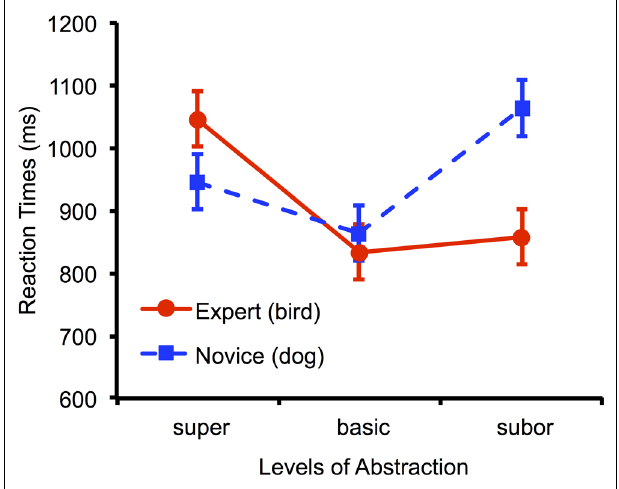
FIGURE 1 | Mean correct categorization response times for a novice domain (dogs) and an expert domain (birds) measured online. FollowingTanaka andTaylor (1991), bird experts were tested in a speeded category verification task where they categorized images at the superordinate ( animal ), basic ( bird or dog ), or subordinate (specific species or breed) level. In their novice domain (dogs), a classic basic-level advantage was observed, whereby categorization at the basic level was significantly faster than the superordinate ( t 22 = 2.67, p = 0.014) and subordinate level ( t 22 = 6.75, p < 0.001). In their expert domain (birds), subordinate categorization was as fast as basic-level categorization ( t 22 = 0.81, p = 0.429).This replication was conducted using an online Wordpress + Flash custom website with only 23 participants from a single short 10 min experimental session. Error bars represent 95% confidence intervals on the level × domain